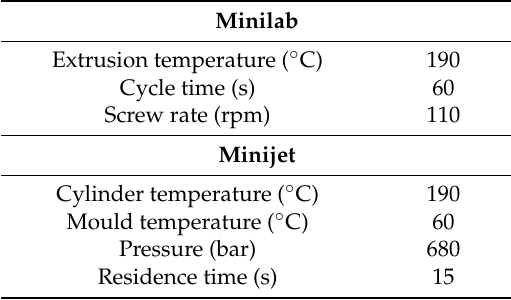
Table 2. Processing conditions of Minilab and